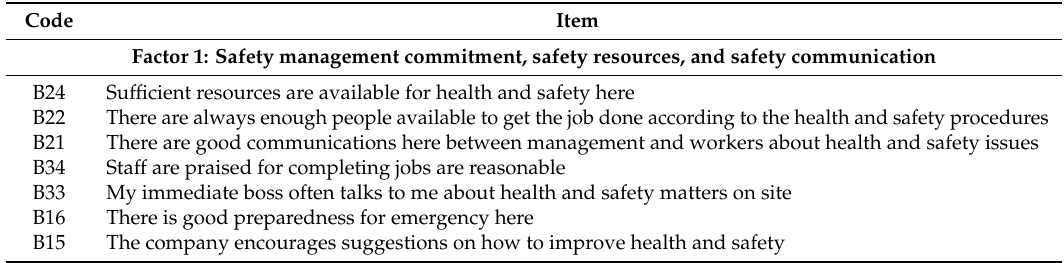
Table A1. Sixteen items measuring safety climate of